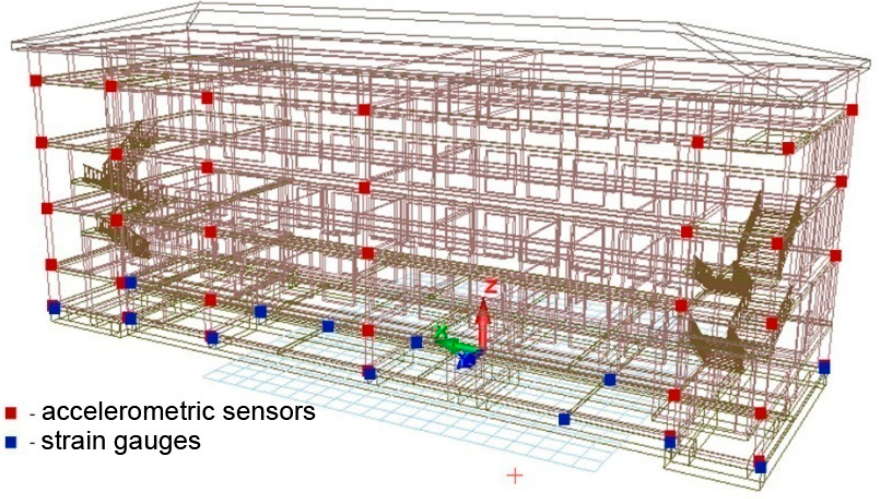
Figure 4. Placement of the sensor network of the geotechnical monitoring system.